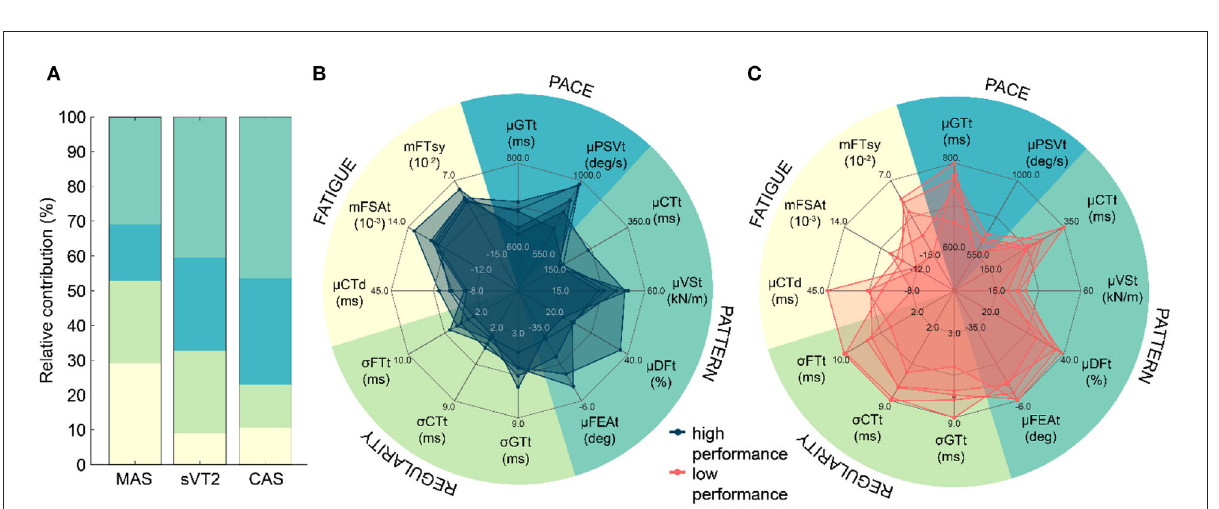
FIGURE6 Selected metrics and their categories. (A) Relative contribution of metric categories to each endurance performance variable. (B) Biomechanical profile for top 5 (high performance) participants according to their MAS. (C) Biomechanical profile for bottom 5 (low performance) participants according to their